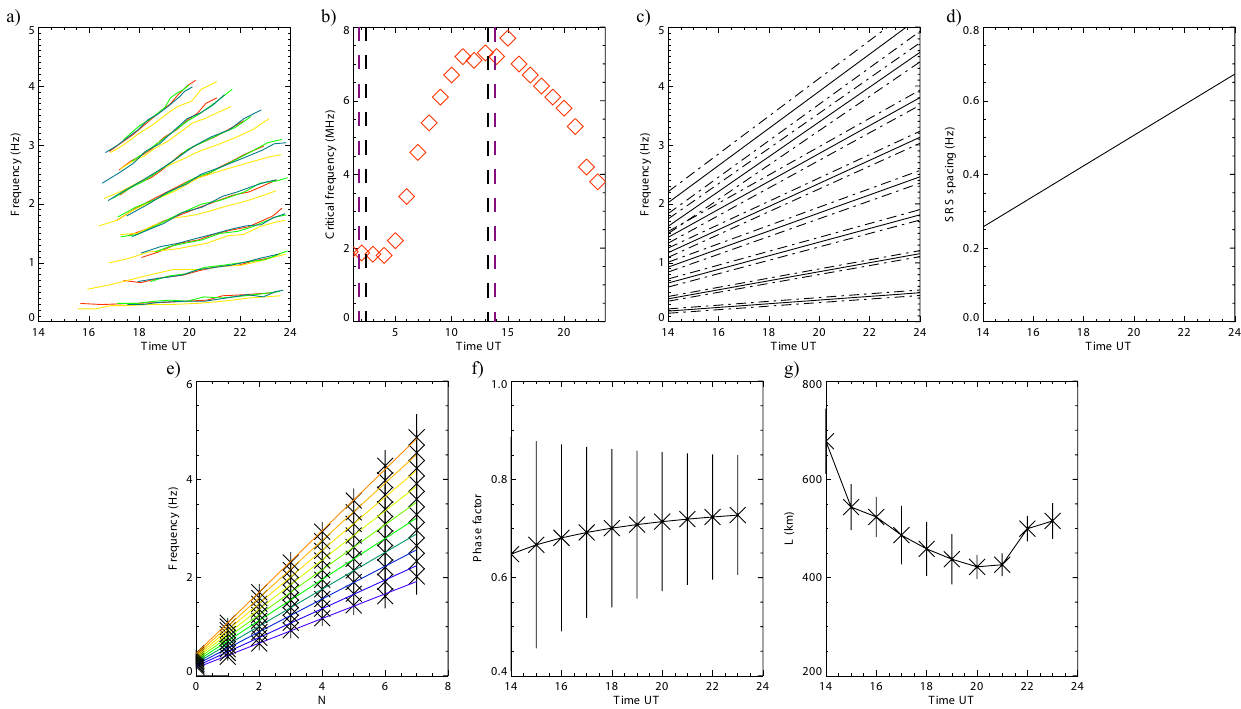
Figure 9. Analysis of the magnetic spectral resonance features seen in pulsation magnetometer data at Sodankylä, Finland on 04/10/98. Panel a) shows the resonance feature frequency evolution over time defined using method 1 from 4 polarisation components: H (red line), D (yellow), RH (green) and LH (blue). Panel b) shows the diurnal f O F2 critical frequency variation from a co-located ionosonde in red diamonds, with the time of the terminator crossing Sodankylä on the ground and at 100km altitude in black and purple dashed lines respectively. Panel c) shows least squares regression lines through the harmonic points plotted in panel a), with error margins shown as dot-dashed lines given by the standard deviation of these points. Panel d) plots the function of harmonic spacing with time, as calculated from the harmonics plotted in panel c). Panel e) shows frequency plotted against harmonic number for each hour from 14-23 UT, with least squares regression lines through these points going purple-orange in time. Panels f) and g) show the evolution of wave phase factor and L with time.